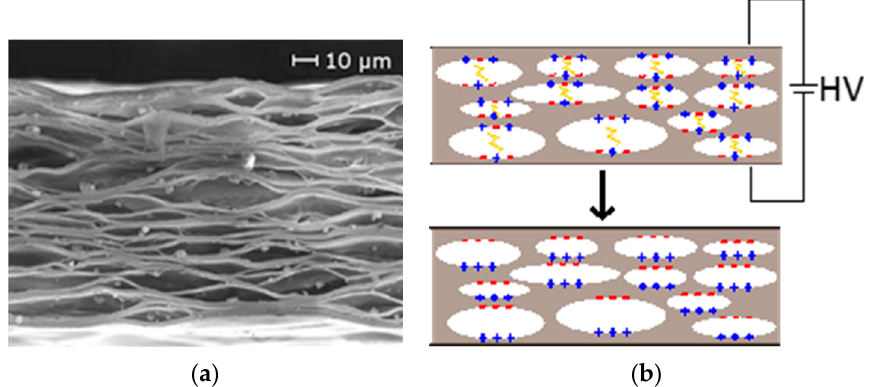
Figure 1. ( a ) Cellular polypropylene (cPP) films have an internal structure with voids which provides low acoustic impedance close to that of air. (©EMFIT Ltd.) ( b ) The film is polarized with corona discharges. The charge is trapped at the surfaces of the voids creating quasi-permanent polarization equivalent to a voltage V 0